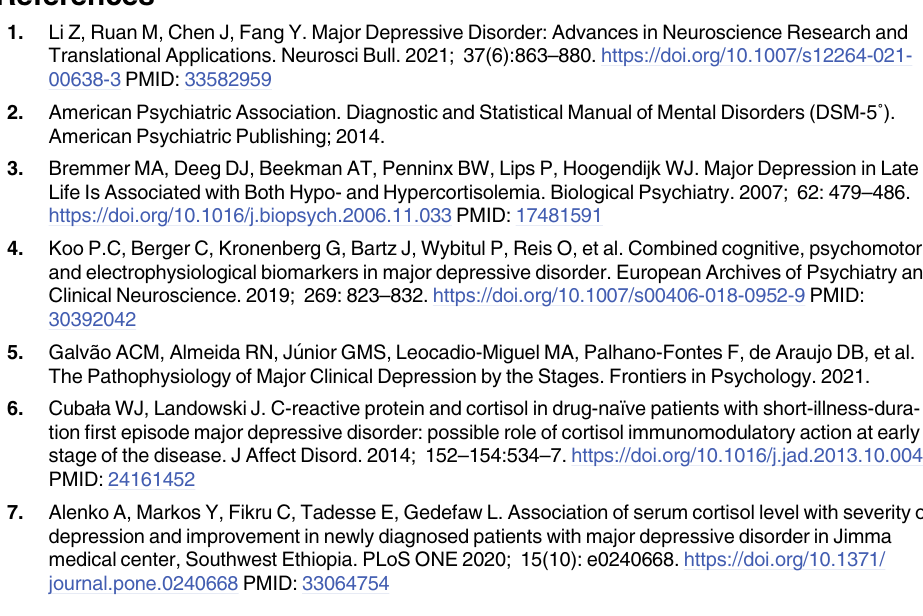
S2 Fig. Importance of sociodemographic characteristics and BMI for the discrimination of groups. Random forest-based algorithm (Boruta): A) Patients with first episode of major depression (MD, n = 30) and control group (CG, n = 32). B) MD and Patients with treatment- resistant major depression (TRD, n = 28). Colors: green = relevant characteristic; yellow = tentative of relevance; red = no relevant characteristic; blue = randomly shuffled data at a maximum, mean and minimum level. S1 Table. Clinical and sociodemographic characteristics of